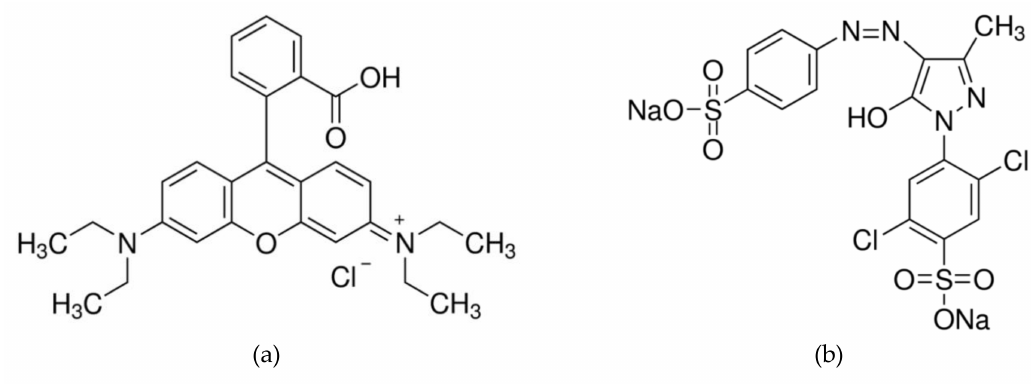
Figure 1. Structural formulas of rhodamine B (RB) ( a ) and acid yellow 17 (AY17) ( b